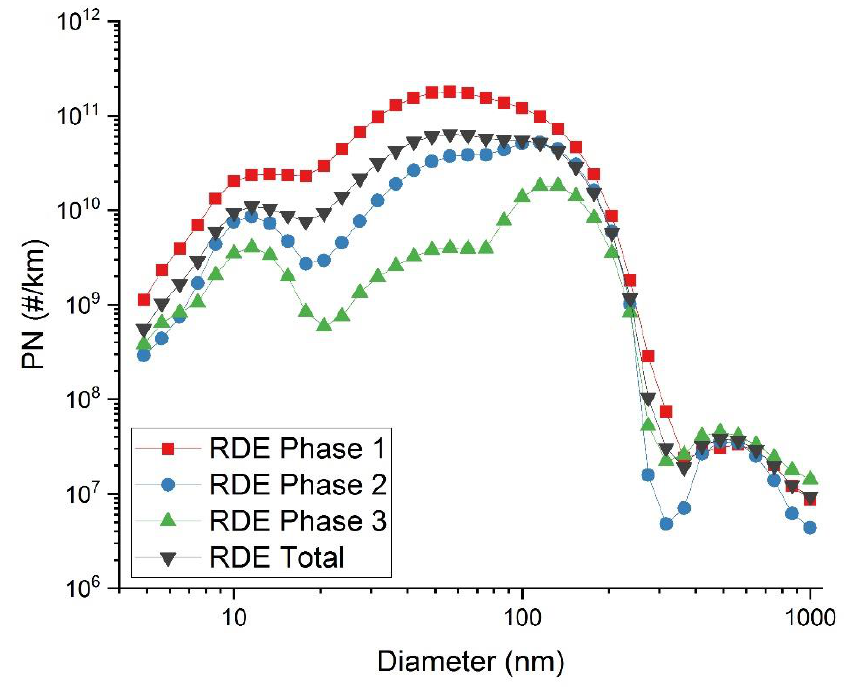
Figure 16. Average size distributed PN emission factors from individual phases and total RDE cycles.